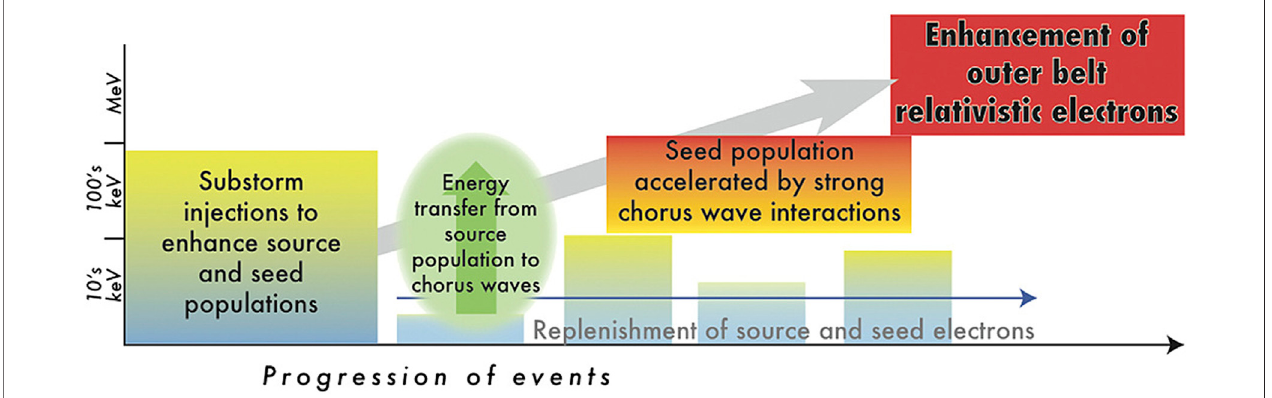
FIGURE 6 | Sequence for MeV acceleration by chorus waves in the Earth ’ s outer radiation belt (from Jaynes et al., 2015).